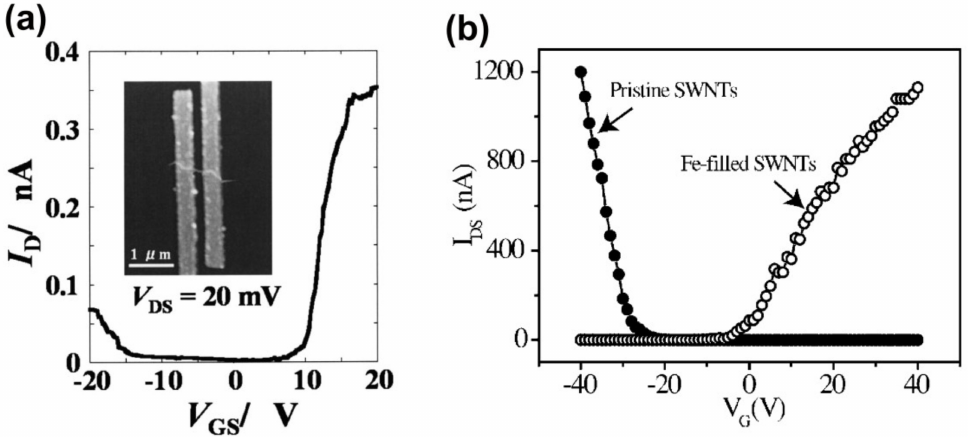
Figure 1. ( a ) I D – V GS characteristics of a Gd@C 82 metallofullerene peapods-FET ( V DS =20 mV). The inset shows an atomic force micrograph of the same Gd@C 82 peapods-FET. Reprinted from [89] with the permission of AIP Publishing. ( b ) Source-drain current ( I DS ) versus gate bias ( V G ) at a gate voltage ( V DS ) of 1 V for pristine SWCNTs and Fe-filled SWCNTs. Reprinted from [78] with the permission of AIP